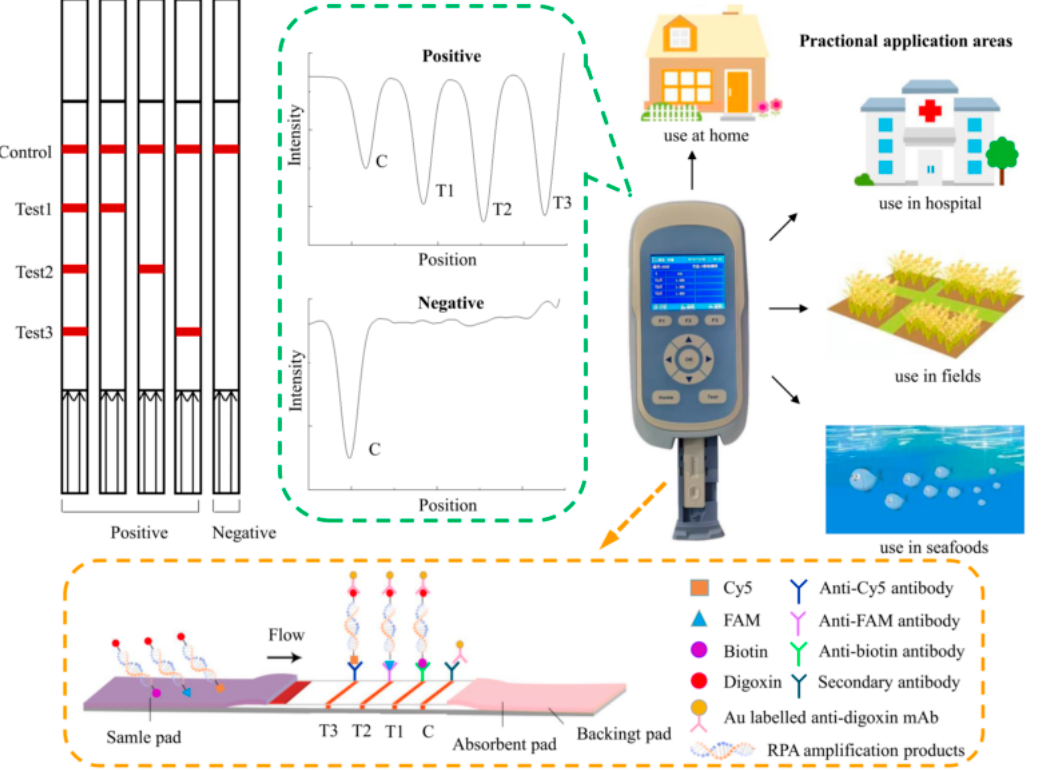
Figure 1. The working principle and potential application of the triplex recombinase polymerase amplification combined with a lateral flow dipstick (LFD-RPA) assay.